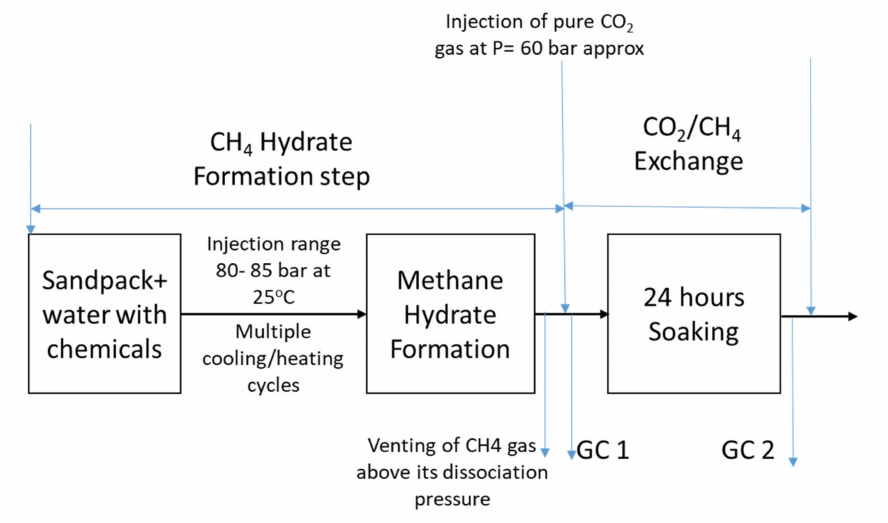
Figure 3. Schematic of the experimental investigation. GC1 is the gas sample collected just after CH 4 venting and CO 2 gas injection; GC2 is the second gas sample collected after 24-h soaking